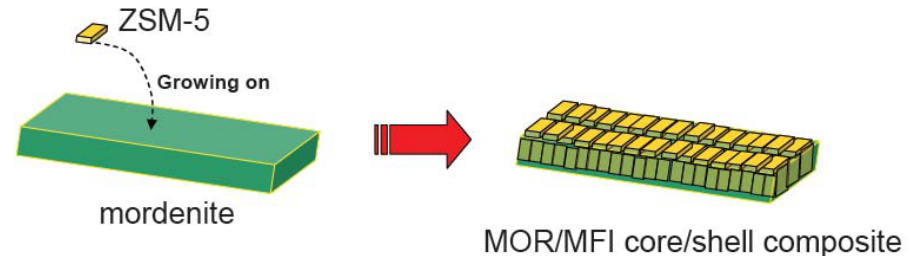
Figure 5. Growth of MOR/MFI core/shell composite. Reproduced with permission from Elsevier